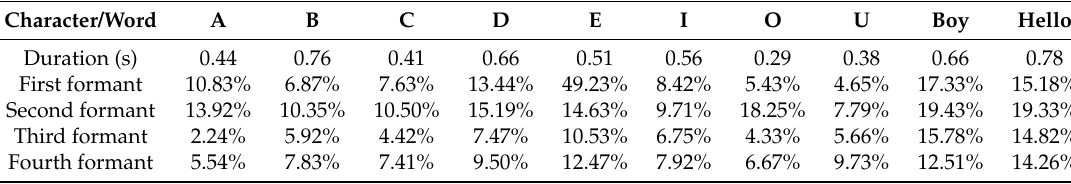
Table 4. Relative errors of the formant frequency for the tested English letters and